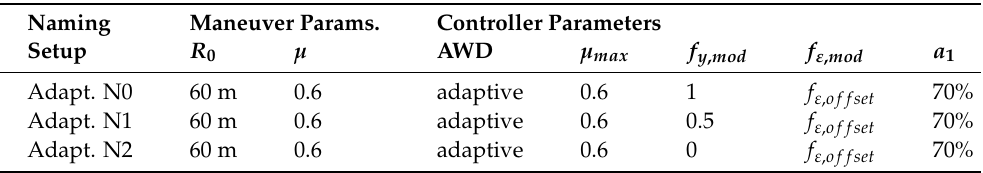
Table 6. Overview of the vehicle configurations and constraints for the investigation of the driving dynamics on wet